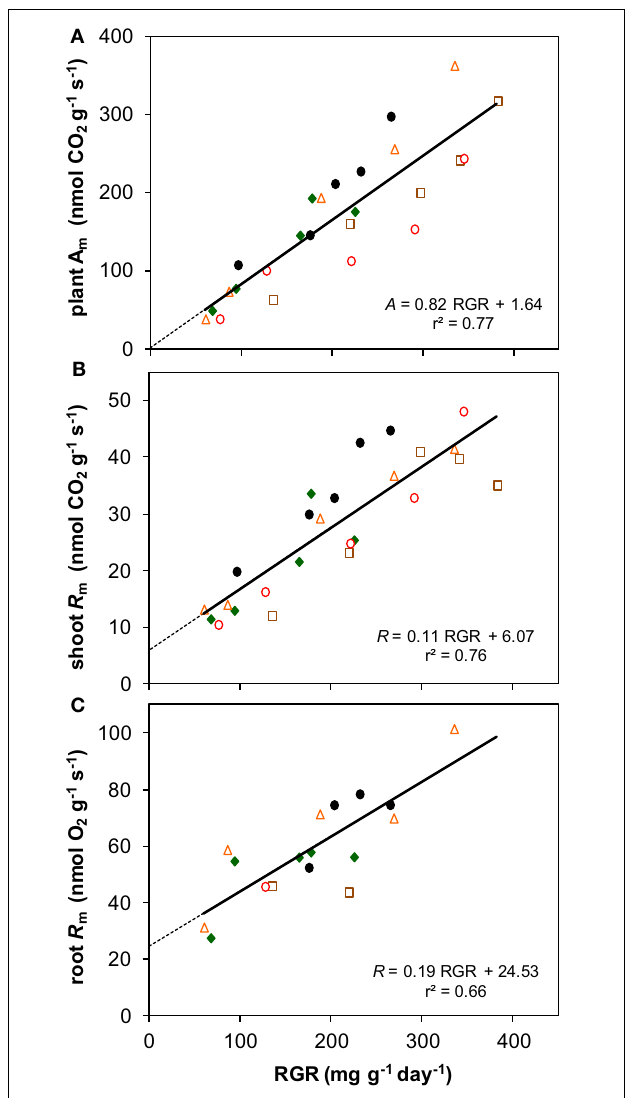
FIGURE 8 | The relationships with RGR of photosynthesis and respiration, both expressed per unit dry mass. (A) Whole-plant A m ; (B) shoot R m ; (C) root R m . Means are plotted, and the equation of the regression lines and the r 2 are shown. of unity (i.e., the whole-plant light compensation point